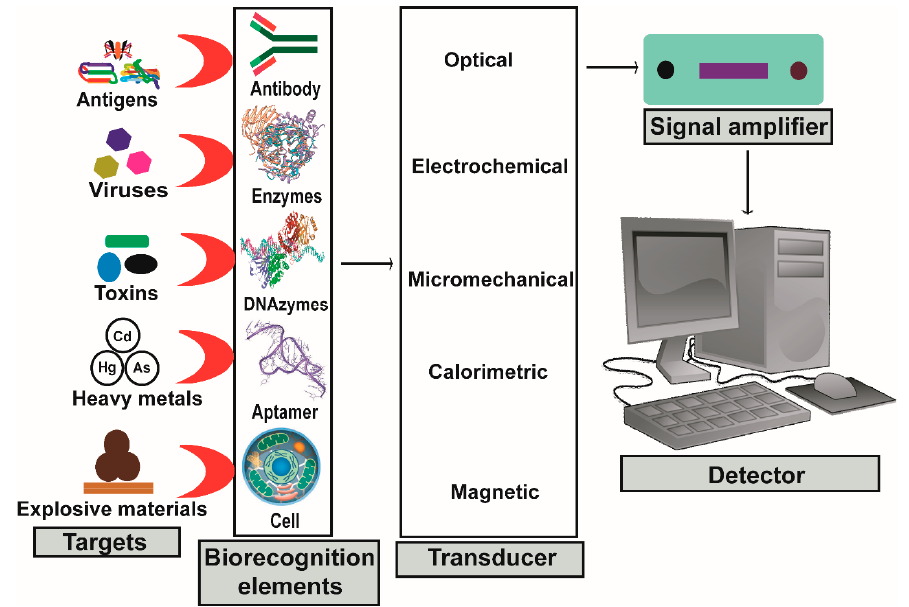
Figure 2. Illustrated scheme of a biosensor and its fundamental components.